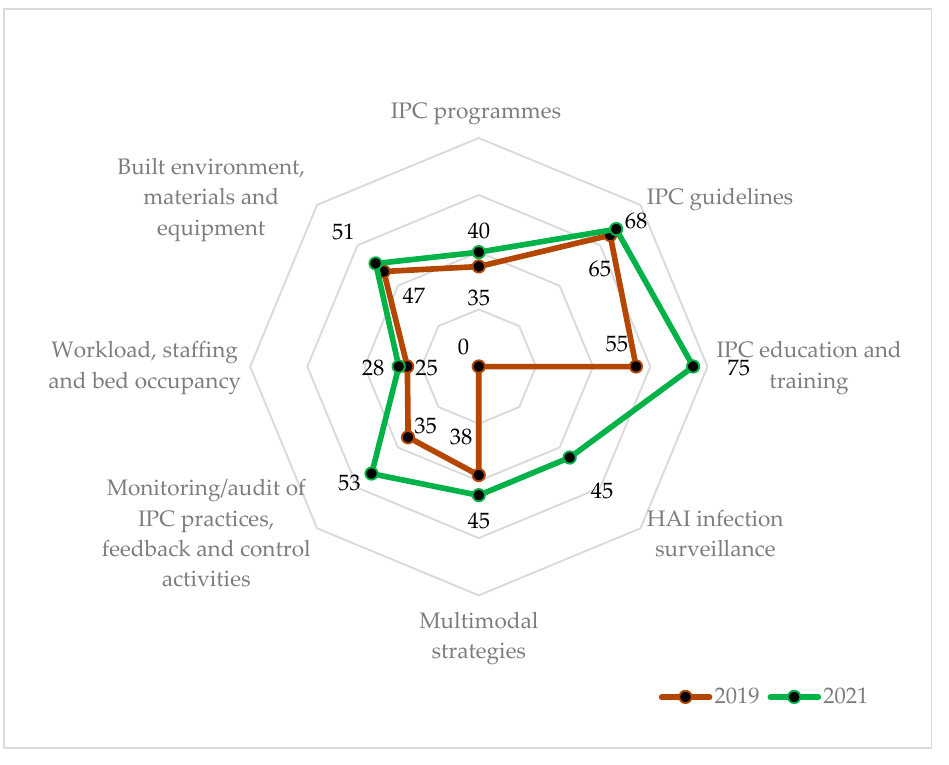
Figure 4. Median IPC compliance percentage scores across eight core components in the eight district hospitals during 2019 (pre-COVID-19) and 2021 (COVID-19 era), Sierra Leone. Note: The radar chart shows the IPC component score emanating from the centre (0%) expanding outwards to a maximum of 100%. The 2021 scores (green line) lie outside the 2019 scores (red line), indicating overall improvement in all the components of IPC. Abbreviation: IPC = Infection, Prevention and Control; HAI = Healthcare Associated Infection.